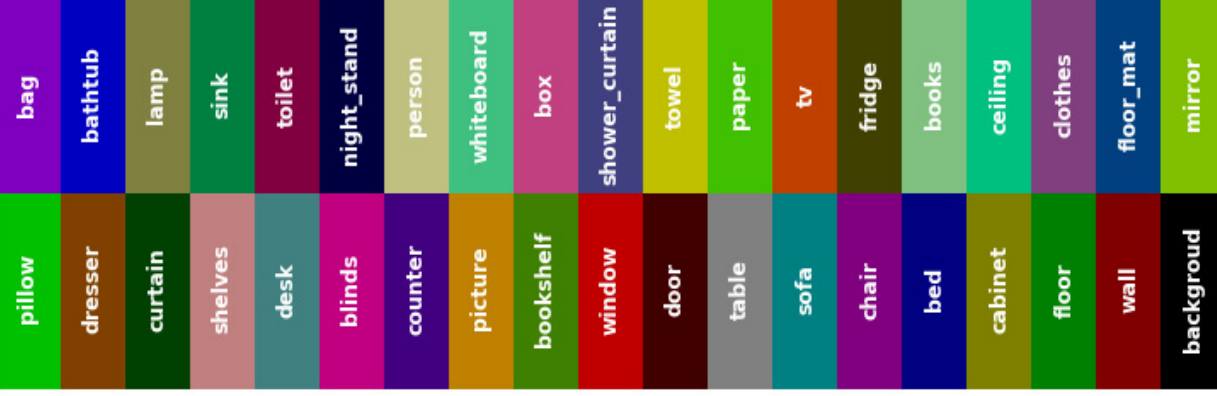
Figure 3. The legend of semantic